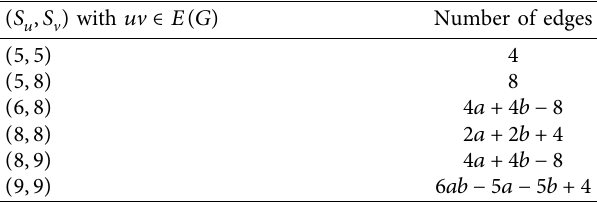
Table 9: Edge partition of T 2 [ a,b ]